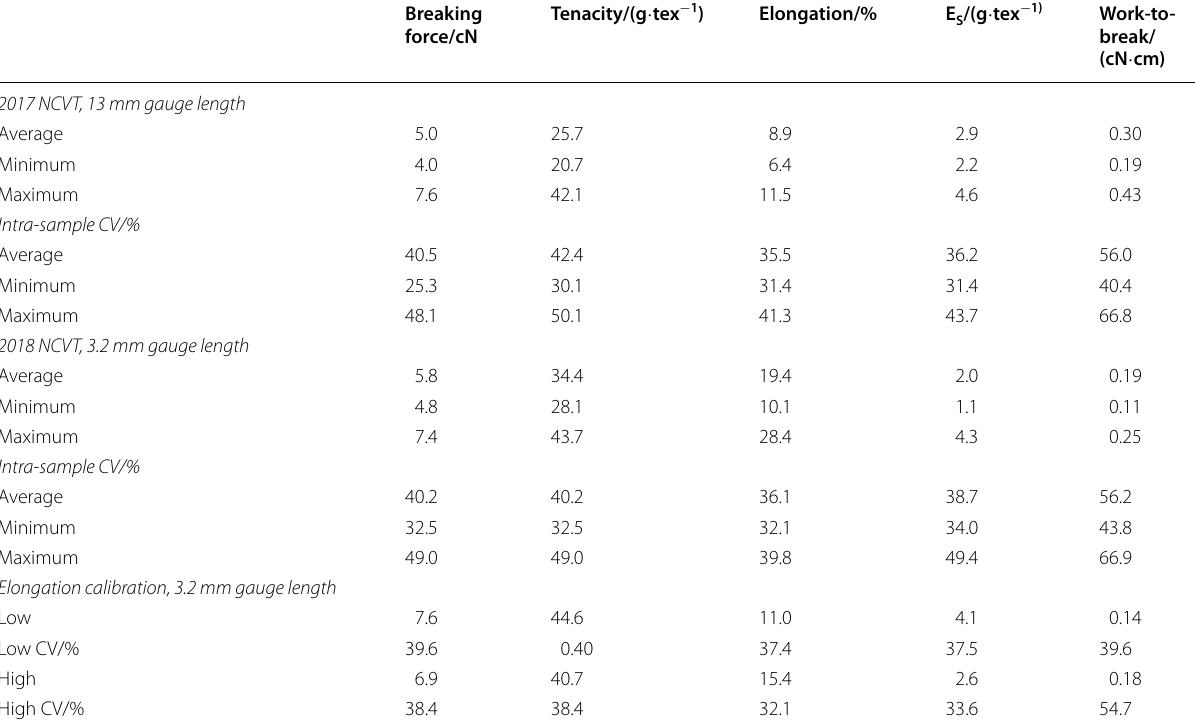
Table 4 Average single fiber tensile